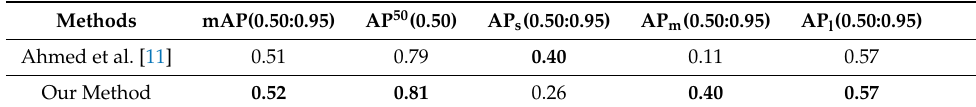
Table 2. Comparison between the proposed method and previous state-of-the-art results on the RESIDE dataset. AP s denotes average precision for the small area, whereas AP m represents the average precision for the medium area and AP l depicts the average precision for the large area. The IoU threshold is also defined in the table. The best results are in bold.